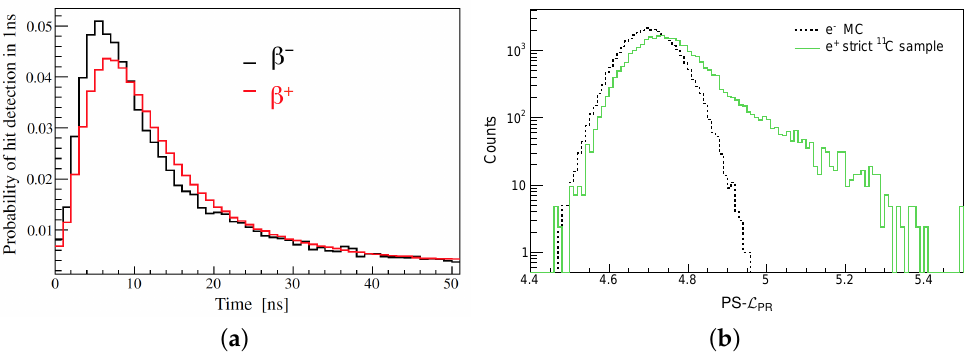
Figure 3. β − (electron) and β + (positron) separation in Borexino. β − distributions are based on Monte Carlo simulations. β + distributions represent a pure sample of 11 C cosmogenic events selected from data. ( a ) Hit time profiles of β − s’ and β + s’ after TOF subtraction. The two distributions show a similar behavior. From [21]. ( b ) PS- variable in the energy window from 400 to 650 N h . From L PR